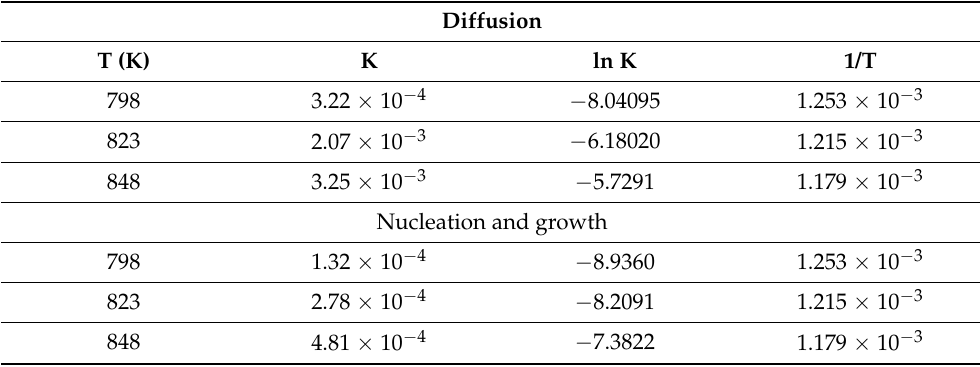
Table 4. Reaction constants calculated at each homogenization treatment temperature, with its respective values of Ln K and 1/T.